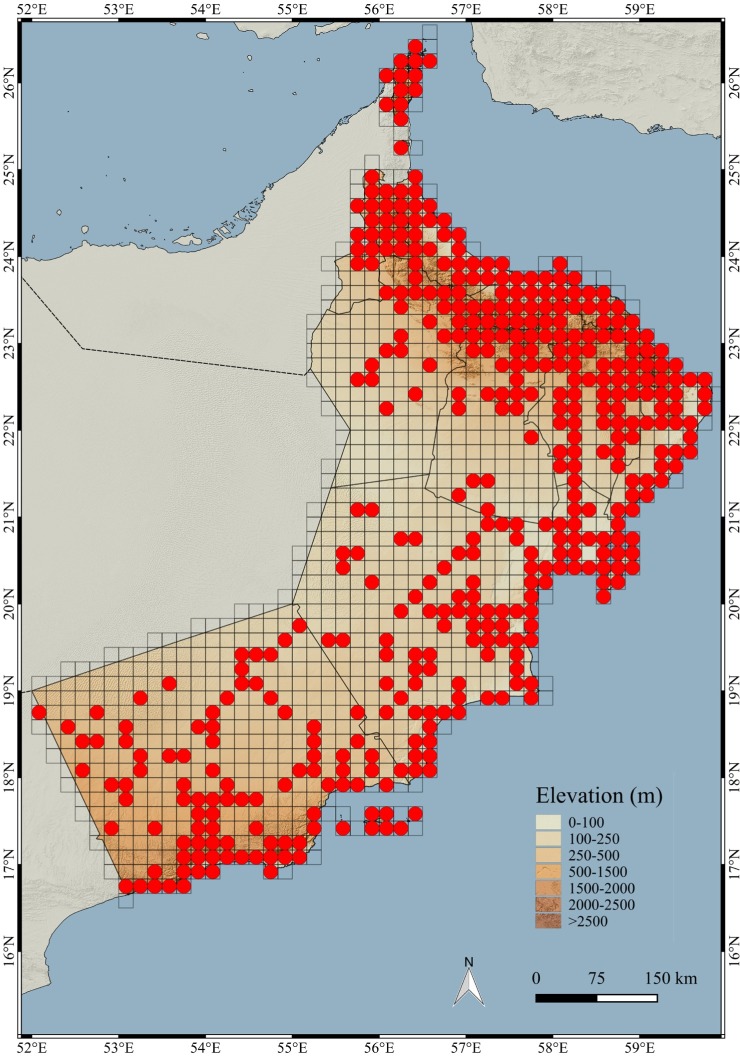
Map of Oman indicating the sampling effort.Grids of 10 arc-minutes (~18km) with observations (red dot). Empty grid cells are either due to no observation or no sampling.